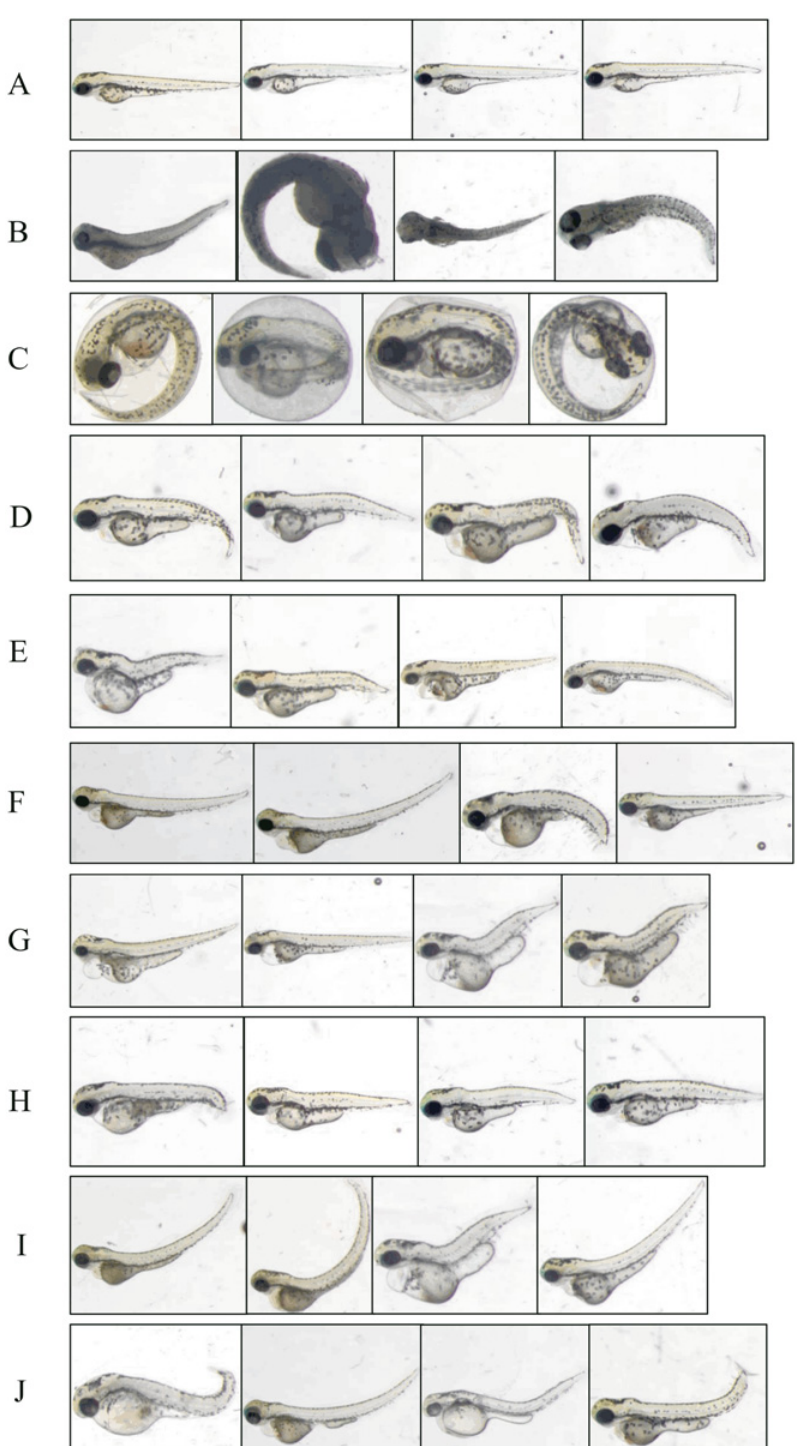
Figure 2. Examples of images representing all the analyzed phenotypes. “ Without phenotype ” defect, also called “ Normal ” embryos (A) are without any phenotype. The “ Dead ” phenotype (B) is shown as totally necrosed, while the “ Chorion ” phenotype (C) represents embryos that are still located in their chorion. In “ Down Curved Tail ” (D), the tail is obviously oriented downward compared to the horizontal. “ Hemostasis ” (E) presents a small amount of blood which can be located everywhere in the embryo (mainly in the head or